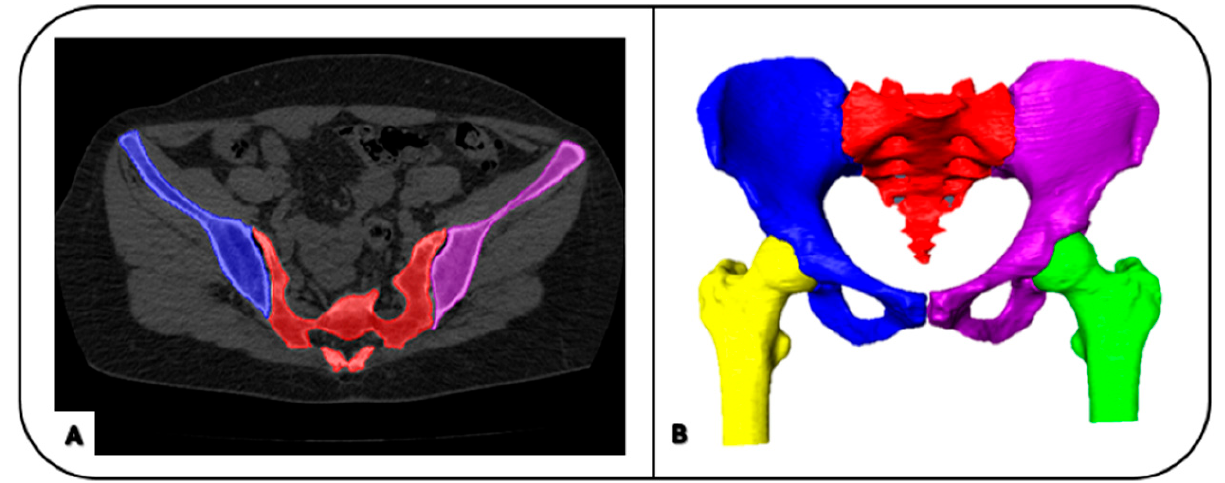
Figure 1. The process of geometrical modeling of the bone shape: image segmentation in the 2D images ( A ) and the final 3D model ( B ) via Amira software.